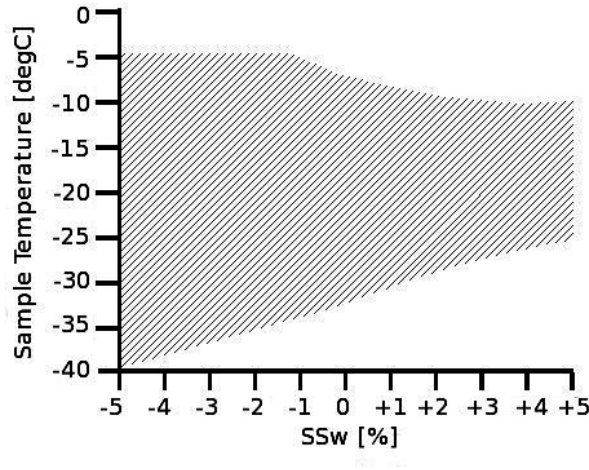
Fig. 8. The range of sample conditions possible within the MINC chamber as indicated by the hatched area on this Sample tempera- ture versus